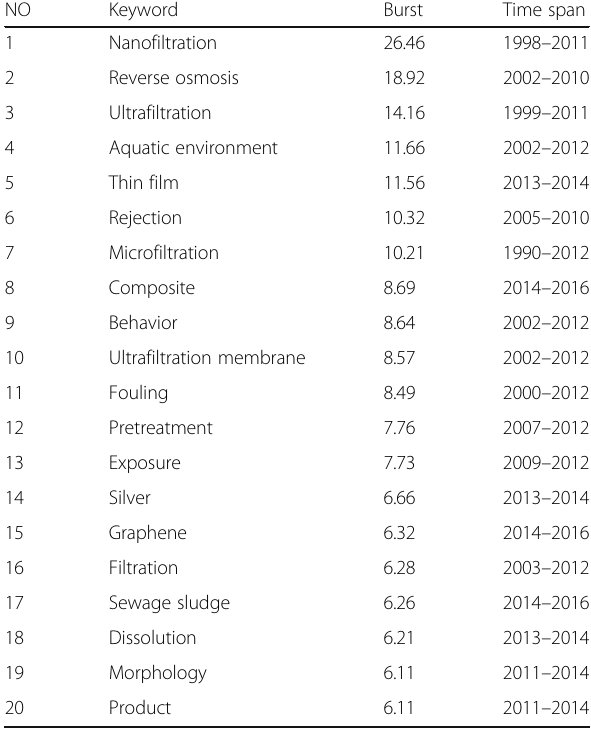
Table 5 listed the top 20 keywords with the strongest bursts